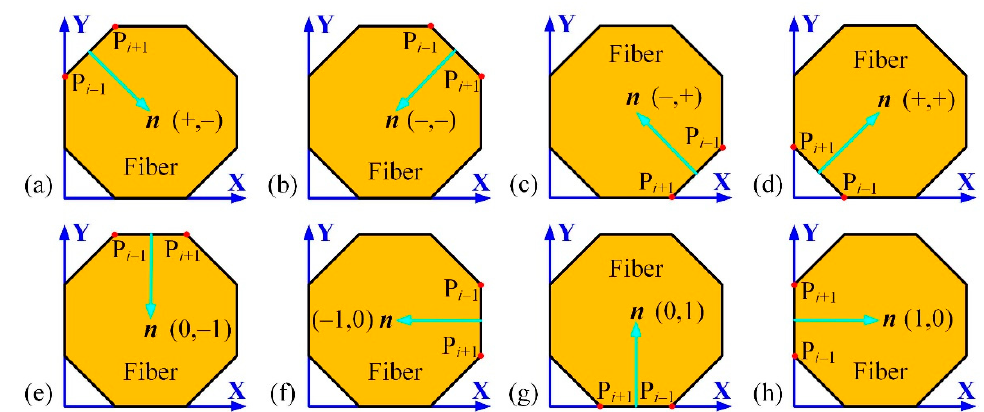
Figure 6. Schematic diagram of the inner normal direction at each point P i . ( a ) n (+, − ); ( b ) n ( − , − ); ( c ) n ( − , +); ( d ) n (+, +); ( e ) n (0, − 1); ( f ) n ( − 1, 0); ( g ) n (0, 1); ( h ) n (1, 0)